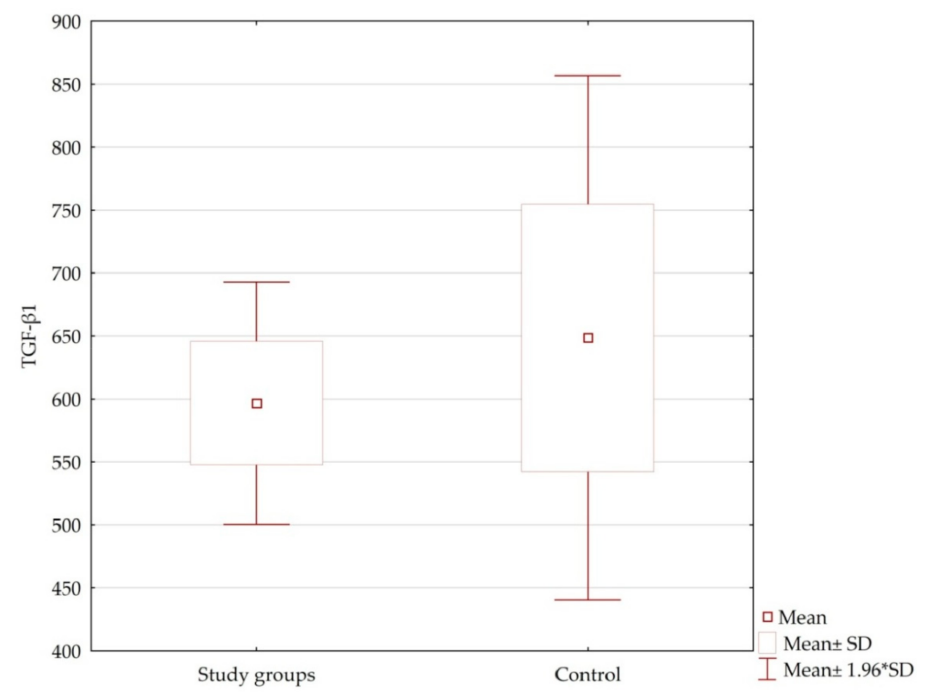
Figure 1. Plasma levels of TGF- β 1 in the study groups and